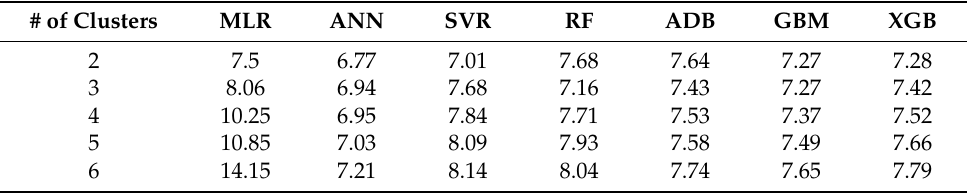
Table 3. Forecasting performance of Model 2 in terms of MAPE according to the number of clusters. # of Clusters